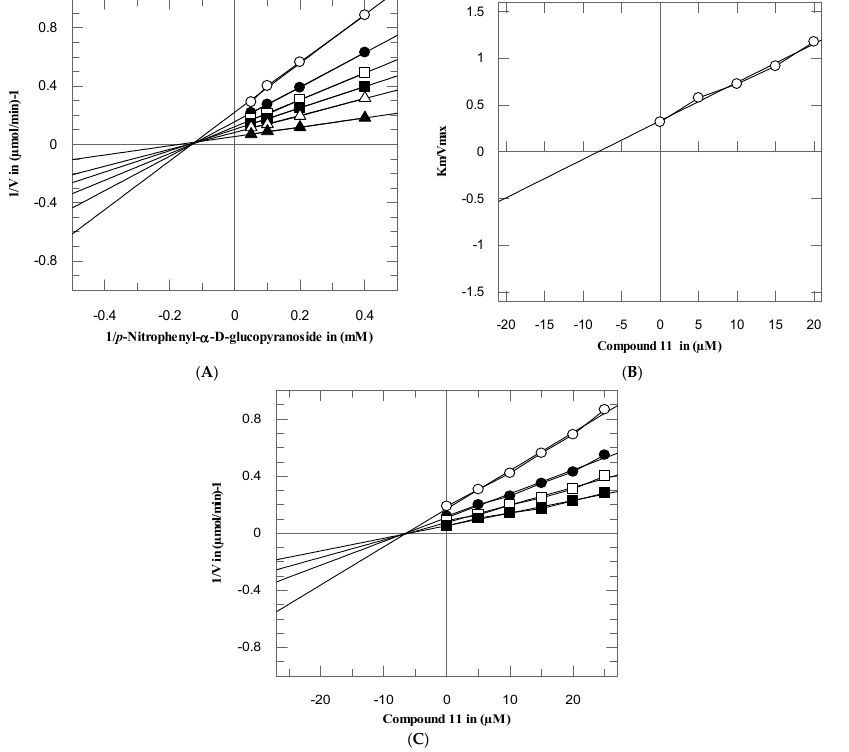
Figure 6. The inhibition of α -glucosidase by compound 11 ( A ) Lineweaver–Burk plot of reciprocal of rate of reaction (velocities) vs. reciprocal of substrate ( p -nitrophenyl- α -D-glucopyranoside) in the absence ( (cid:78) ), and in presence of 5 ( ∆ ), 10 ( (cid:4) ), 15 ( (cid:3) ), 20 ( • ), and 25 µ M ( replot of Lineweaver–Burk plot between the slopes of each line on Lineweaver–Burk plot vs. di ff erent concentrations of compound 11 . ( C ) Dixon plot of reciprocal of rate of reaction (velocities) vs. di ff erent concentrations of compound 11